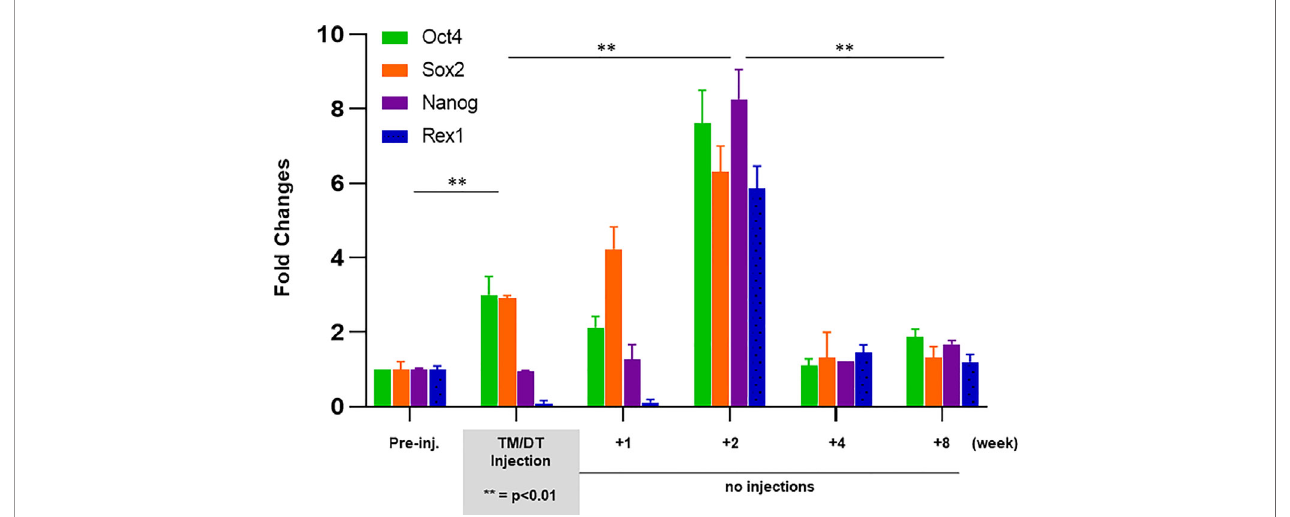
FIGURE 5 | Expression of stem cell markers in thyroid glands from TPOCreER2/iDTR mice: Total mRNA were isolated from each group of mice (n = 4 – 5) as indicated on the X-axis. Five micrograms of total RNA were applied to RT-PCR. Relative expression of each transcript is presented as fold change compared to controls (mean±SEM of three independent experiments). The stem cell markers (Ot4, Sox2) increased after 4 weeks TM/TD treatment (p < 0.01)**. After stopping treatment, all four of the stem cell markers (Ot4, Sox2, Nanog, Rex1) showed a robust increase at 2 weeks which then returned to control levels at 4 to 8 weeks post treatment.